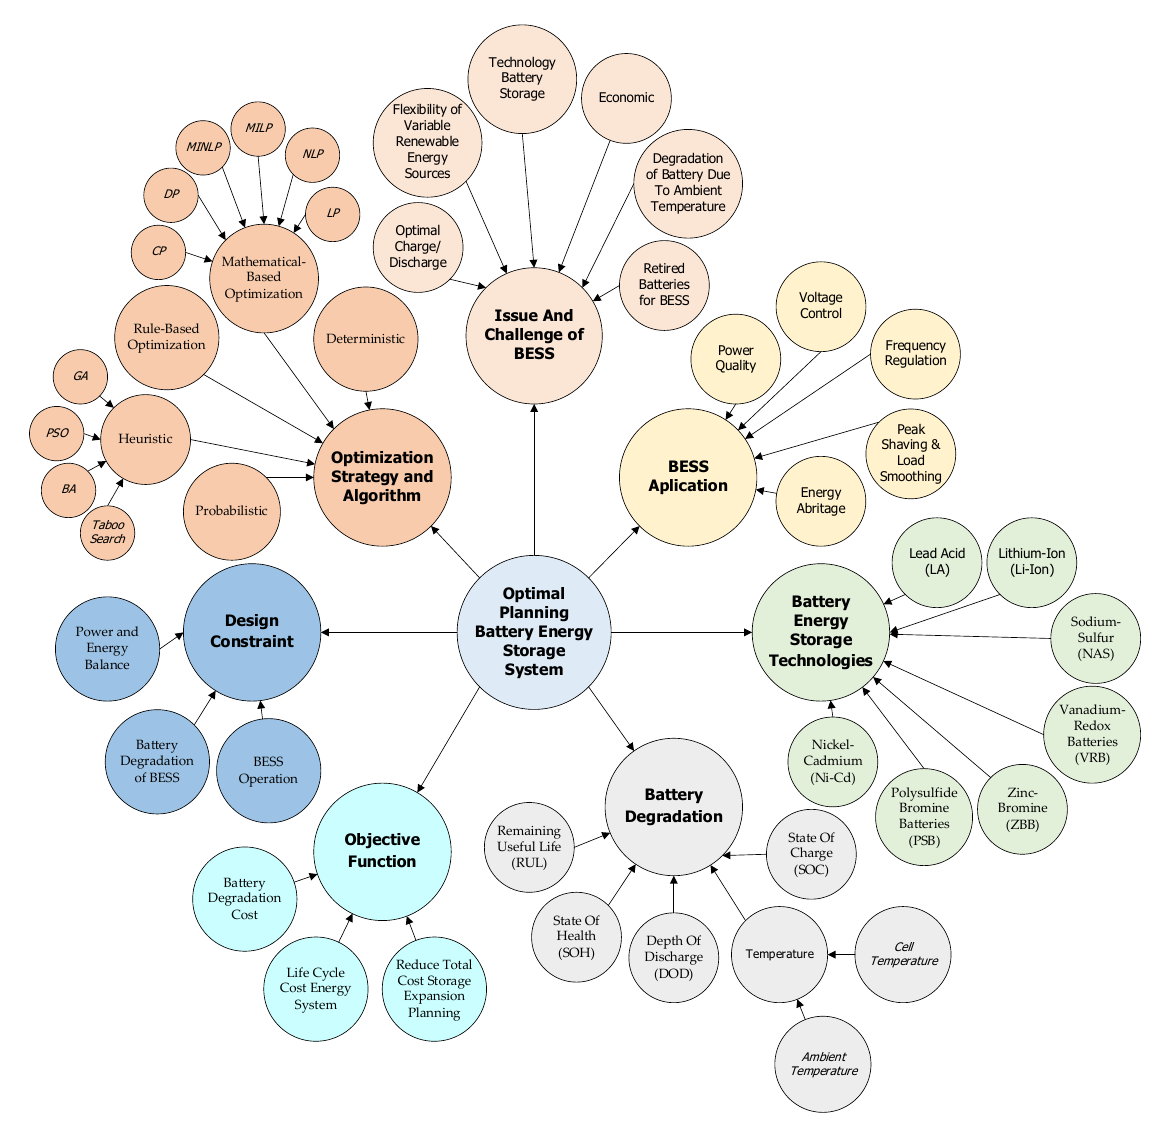
Figure 3. Mind map of BESS optimization.